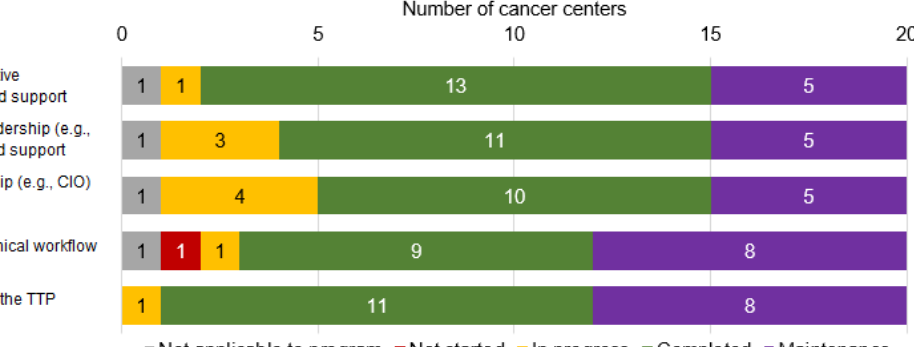
Figure 1. Status of implementation activities for tobacco dependence treatment program buy-in at 20 NCI-designated cancer centers, from July to December 2019. CFO: Chief Financial Officer; CEO: Chief Executive Officer; CMO: Chief Medical Officer; CIO: Chief Information